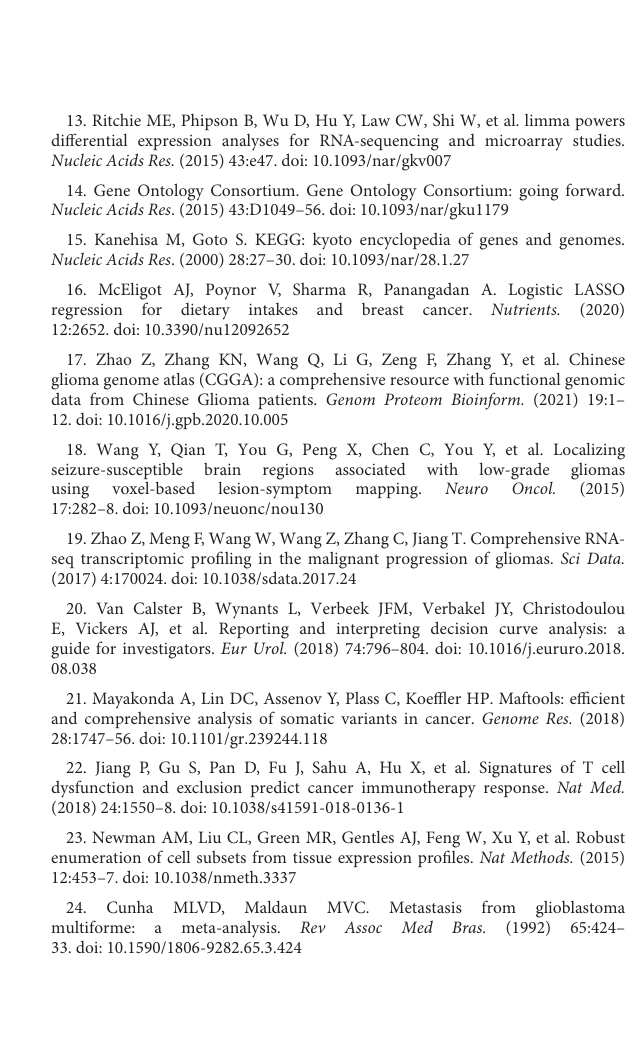
TABLES2 Clinical data of 4 patients in Western